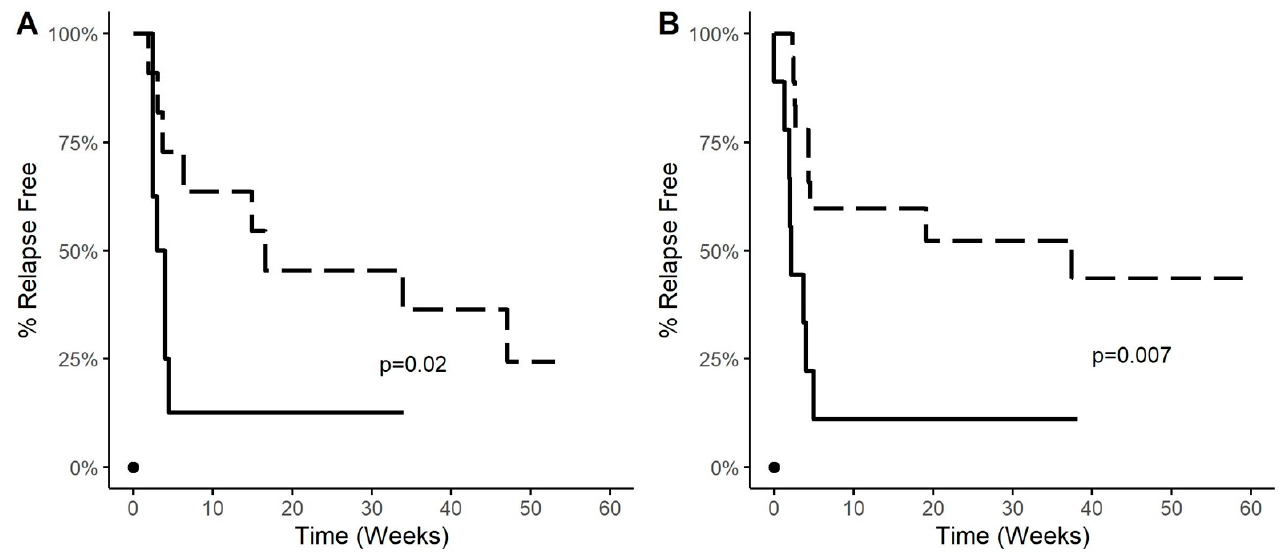
Figure 6. Percent relapse-free newly diabetic NOD mice given PPI L4-20 or insulin B 9-23 intraperitoneally or intradermally together with oral low dose GABA. Newly diabetic NOD mice were given PPI L4-20 (dashed line) or insulin B 9-23 (solid line) ( A ) intraperitoneally (with alum) or ( B ) intradermally (as soluble antigen) as described in Methods. All animals were then given low-dose GABA continuously through their drinking water and were monitored for disease recurrence. Data show the percentage of relapse-free mice in each mouse group following the treatment. In panel A, PPI L4-20 n = 11, and insulin B 9-23 n = 8. In panel B, PPI L4-20 n = 18, and insulin B 9-23 n = 9. p values were calculated by Log-Rank test. “ • ” indicates control untreated newly diabetic NOD mice (data from [25]). Previous studies of mice receiving low dose GABA (alone) observed that only about half of the treated mice went into remission and the responders relapsed within two weeks [25].